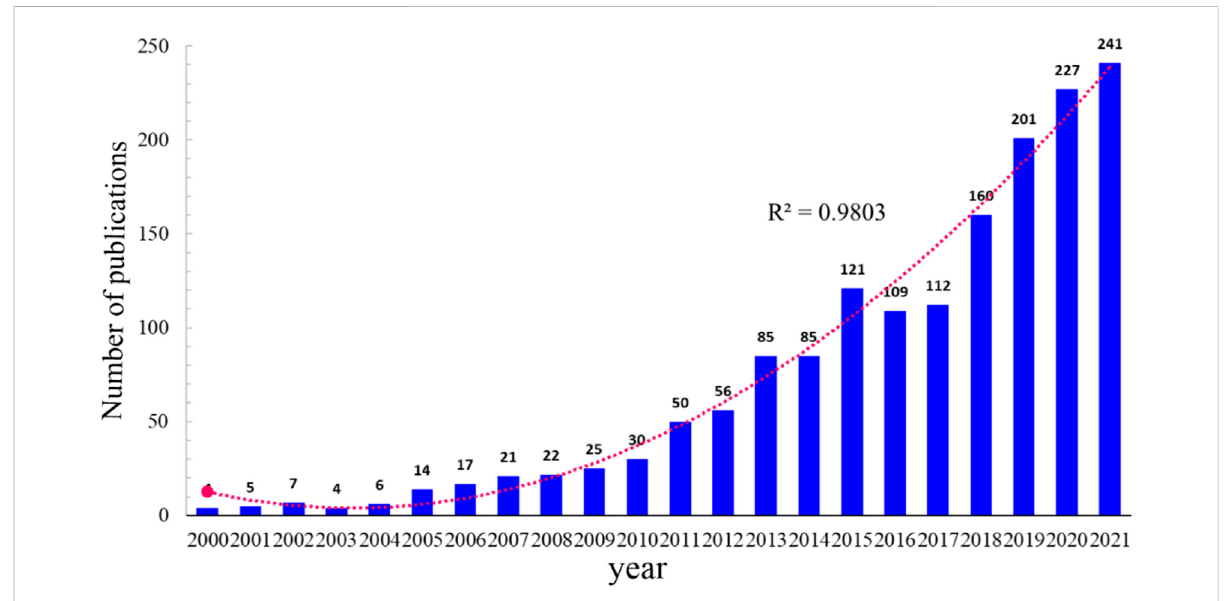
FIGURE 1 Number of publications by year and curve fi tting of the annual growth trend of publications ( R 2 = 0.9803).